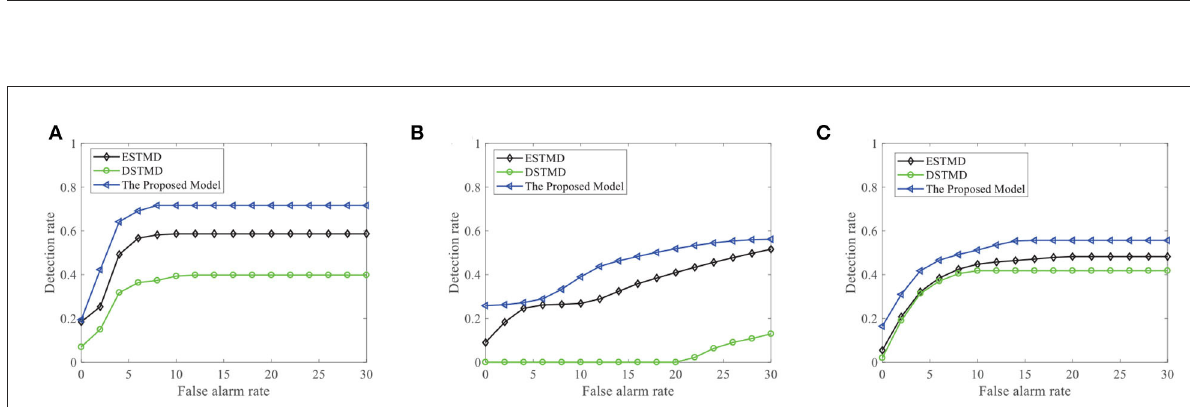
FIGURE14 The detection result of the proposed F STMD on three real videos in comparison to the elementary STMD (ESTMD) and directionally selective (DSTMD) models. (A) Real video 1 (GX010303), (B) Real video 2 (GX010335), and (C) Real video 3 (GX010241). The F STMD achieves better performance than the other two models on all real